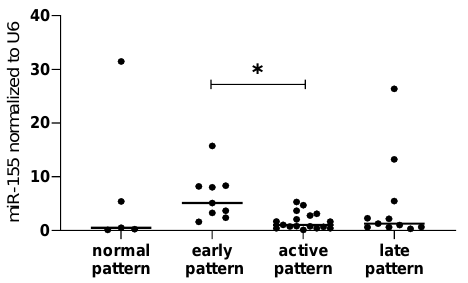
Figure 3. miR-155 expression level in systemic sclerosis patients with different capillaroscopy pat- terns. Data are presented with the median as scatterplot; * p < 0.05.